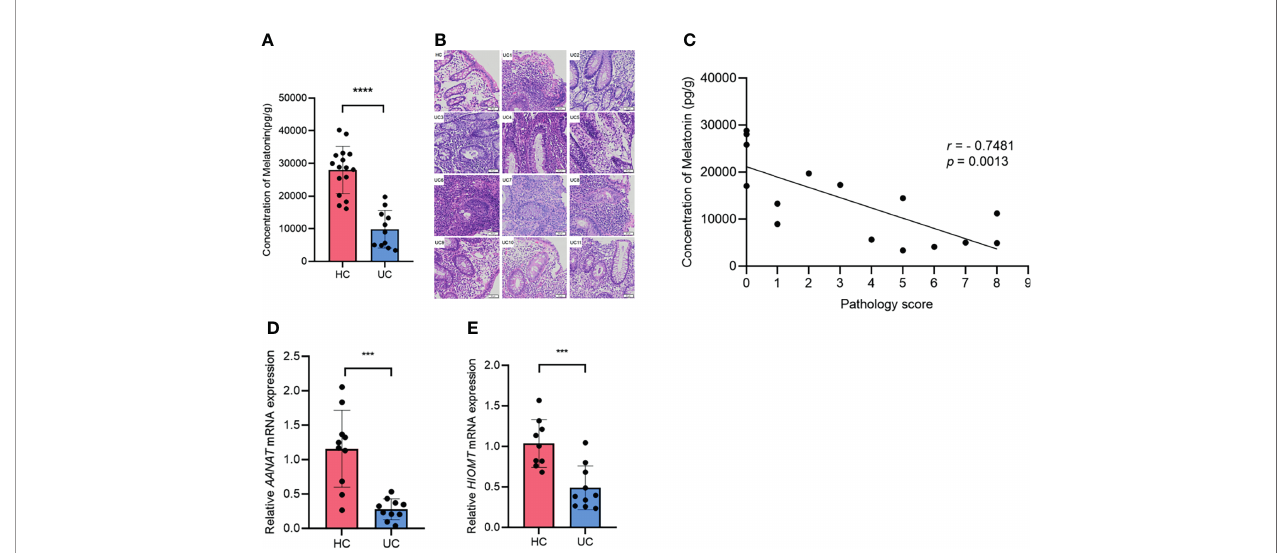
FIGURE 1 | Melatonin in the colon decreases and negatively associates with disease severity in ulcerative colitis (UC) patients. (A) Melatonin concentrations in healthy control (HC) and UC patients were detected by ELISA. (B) Representative H&E staining of colonic sections (×20). (C) Correlation of melatonin concentration and histological severity scores of all 11 UC patients and 4 random HCs. (D, E) AANAT and HIOMT mRNA expression levels in HCs and UC patients (all values were normalized to the HC group). *** p < 0.001; **** p <